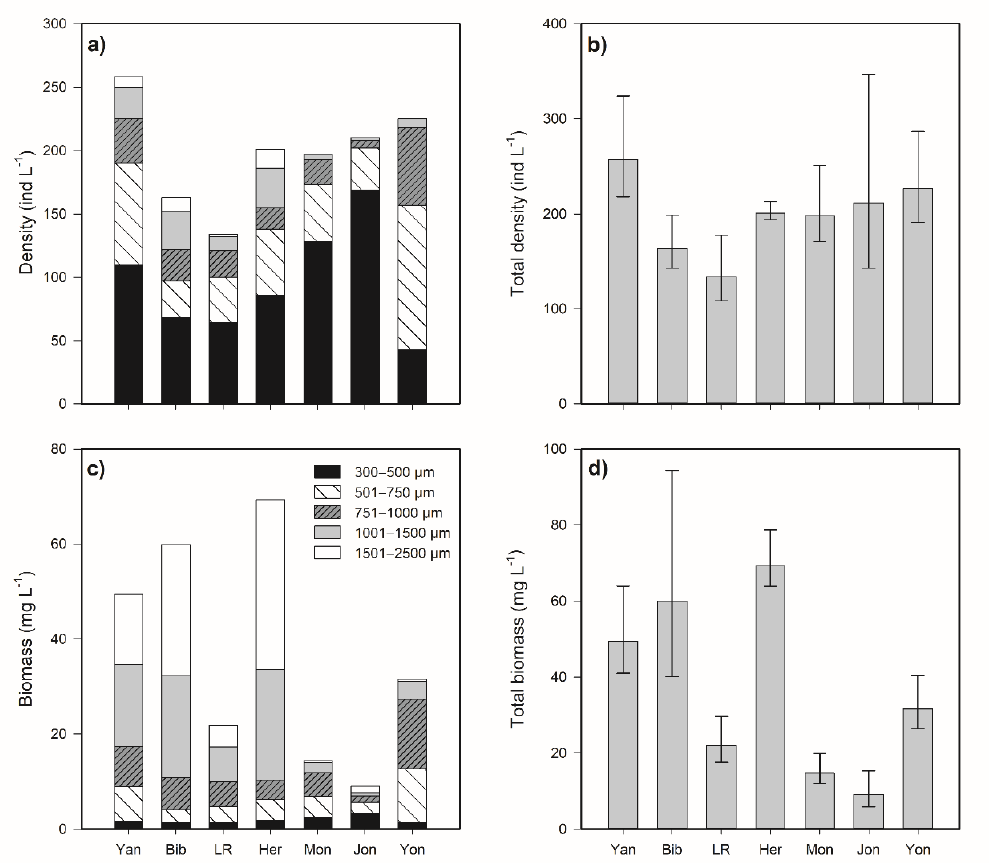
Figure 6. Mean values (± standard deviation, SD) of total and within-zooplankton size groups density and biomass in the seven lakes. ( a ) Density within the five size classes; ( b ) total density (means and SD) in each lake; ( c ) biomass of the five size classes; and ( d ) total biomass (means and SD) in each lake. All size classes are in µm equivalent spherical diameter (ESD). Study lakes are indicated along the x -axis with Yan = Yangebup, Bib = Bibra, LR = Little Rush, Her = Herdsman, Mon = Monger, Jon = Joondalup, and Yon = Yonderup.